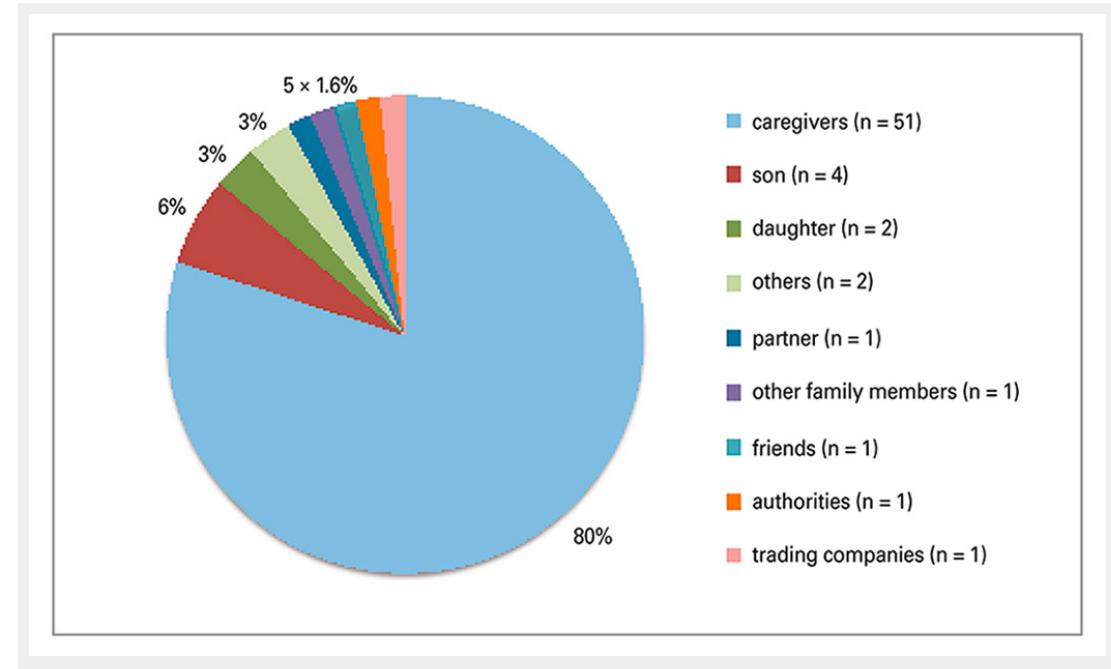
Figure 3c Perpetrators relation to their victim (nursing home resident, n = 64).